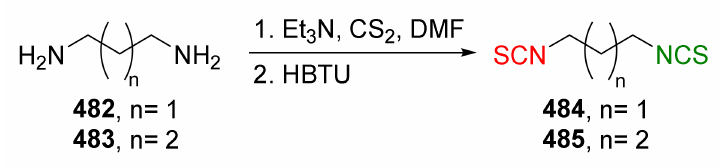
Figure 57. Synthesis of diisothiocyanates 484 and 485 . Synthesized diITC were evaluated in vitro on LoVo and LoVo/DX cancer cell lines. Their IC 50 values on the LoVo cancer cell line were very high and were lower than 2 µ M. Additionally, their biological activities were higher than their mercapturic acid derivatives.